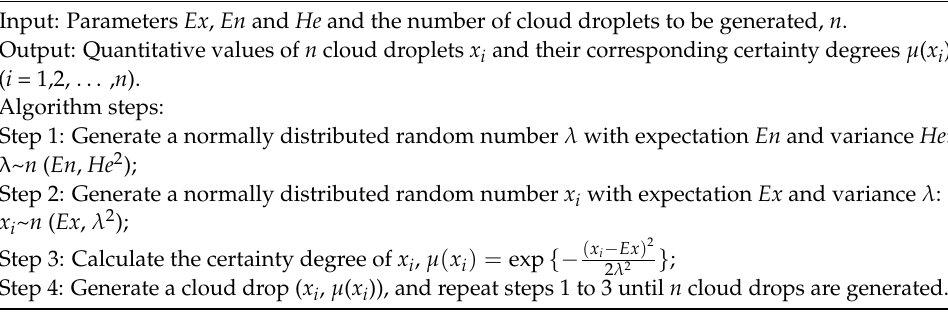
Algorithm 1. Algorithm of forward cloud generator (FCG).